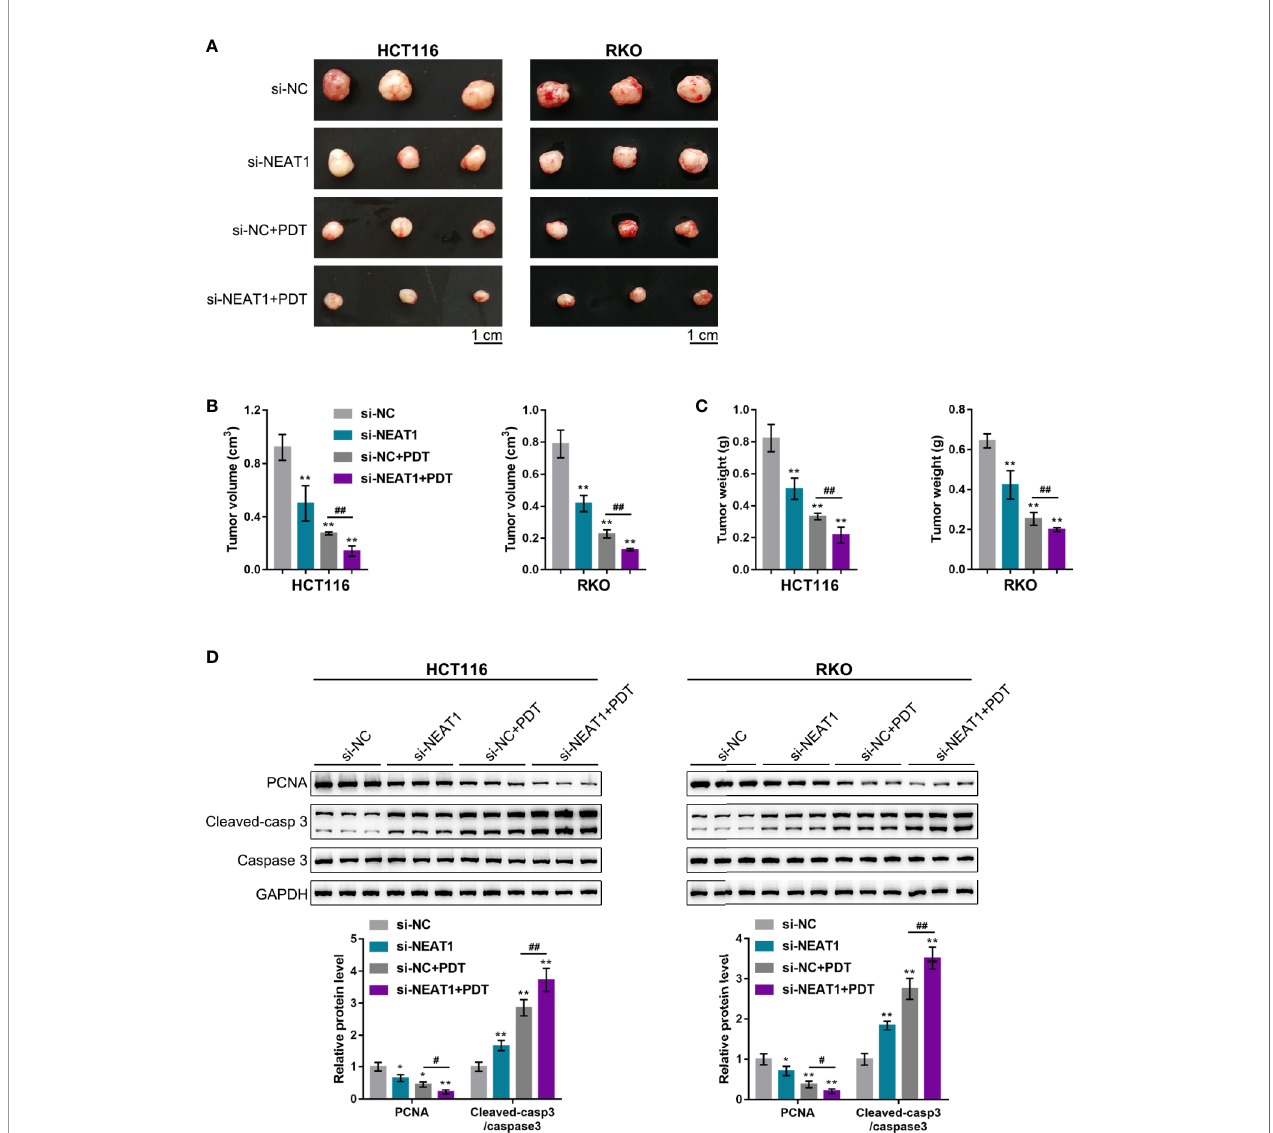
FIGURE 2 | Silencing NEAT1 enhances the repressive effects of PDT on tumor growth in model mice. The subcutaneously implanted tumor model was established in nude mice by injecting HCT116 or RKO cells infected with lentivirus containing si-NC or si-NEAT1. Model mice were treated or non-treated with PDT. On day 27 of cell injection, the tumor volume and tumor weight were examined (A – C) , and the protein levels of PCNA, Caspase 3, and cleaved-Caspase 3 were determined in tumor tissues by Immunoblotting (D) . n= 6. * P < 0.05, ** P < 0.01, compared with si-NC group; # P < 0.05, ## P < 0.01, compared with si-NC+PDT